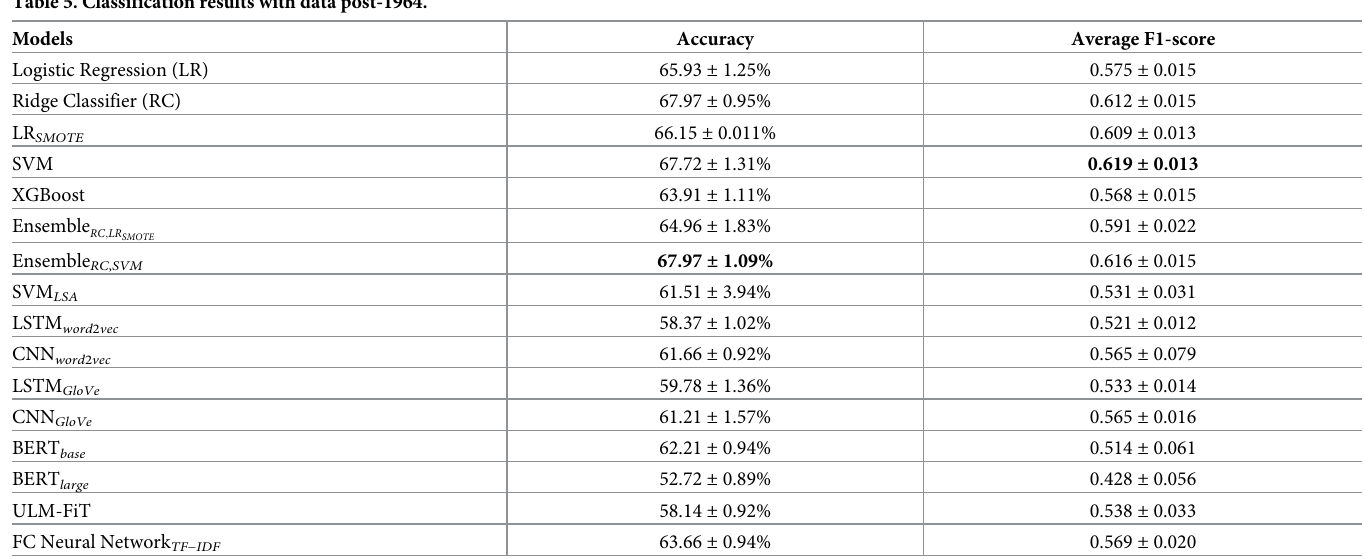
Table 5. Classification results with data